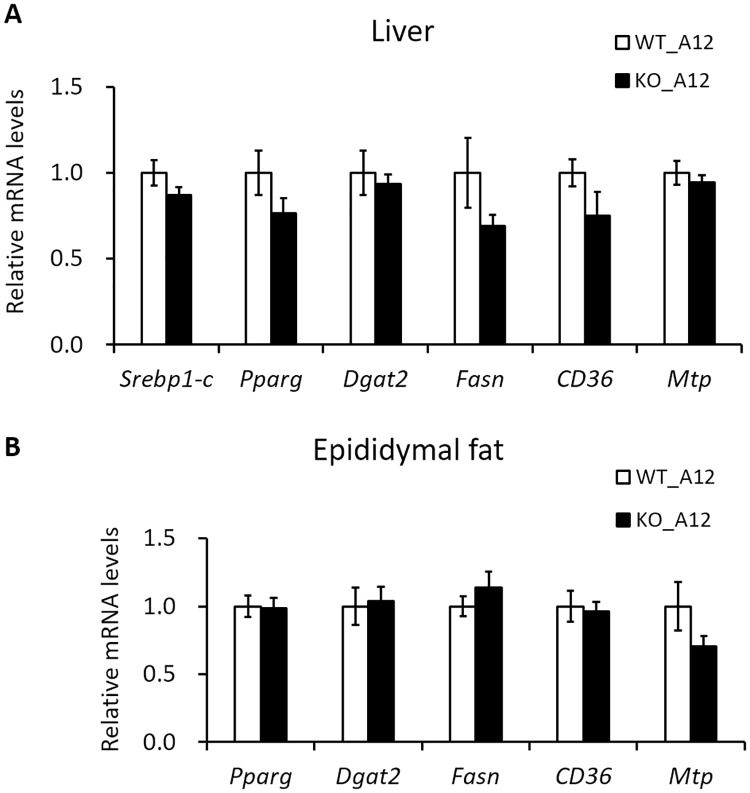
The mRNA levels of lipid metabolism-related genes in the liver and epididymal fat of WT_A12 and KO_A12 mice fed with a high-fat diet for 12 weeks.The mRNA levels were measured by real-time qPCR in the liver (A) and epididymal fat (B). Data were expressed as mean ± SEM. WT_A12 (n = 5–8), KO_A12 (n = 5–8). Srebp1-c, sterol regulatory element binding transcription factor 1c; Pparγ, peroxisome proliferator activated receptor gamma; Dgat2, diacylglycerol O-acyltransferase 2; Fasn, fatty acid synthase; CD36, Cd36 antigen; Mtp, microsomal triglyceride transfer protein.